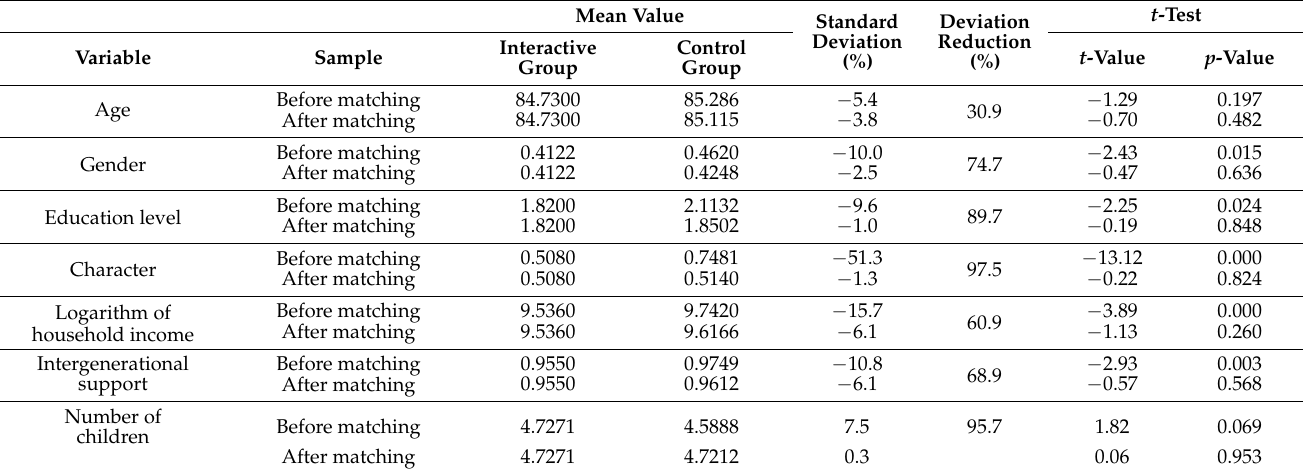
Table 8. Changes in characteristic variables before and after sample matching